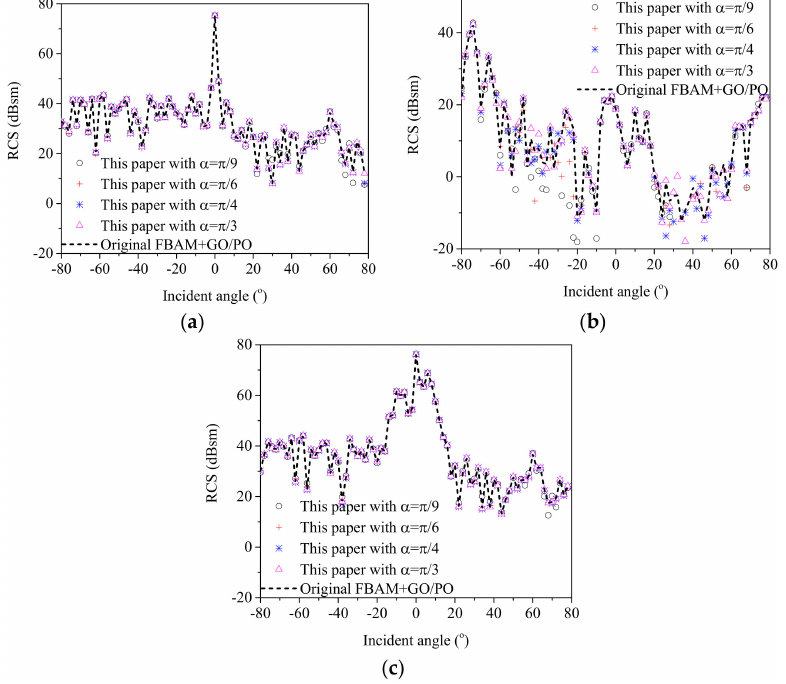
Figure 5. Comparison of calculation accuracy between the proposed way and the original GO / PO method. ( a ) The scattering filed from the ship target. ( b ) The coupling scattering field. ( c ) The total scattering field.